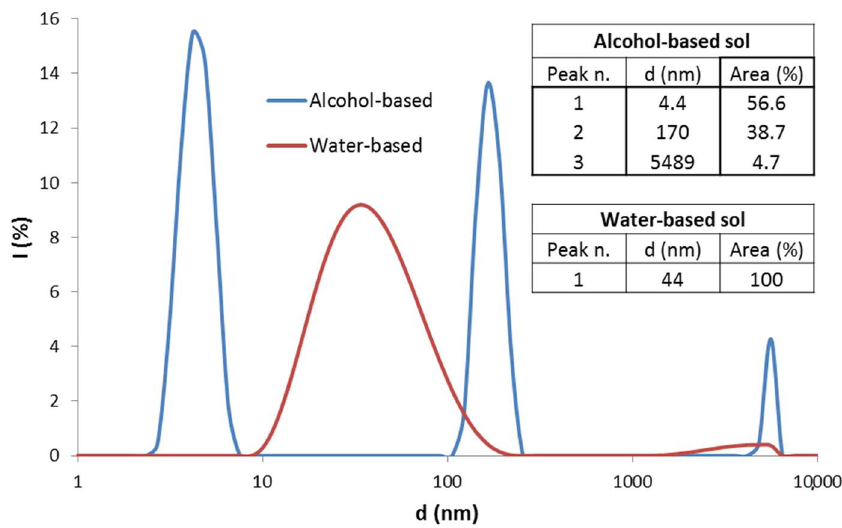
Figure 1. Size distribution of alumina nanoparticles in the alcohol-based (blue line) and in the water-based (red line) sol. Inset tables report the average size for each peak and the related area percentage.